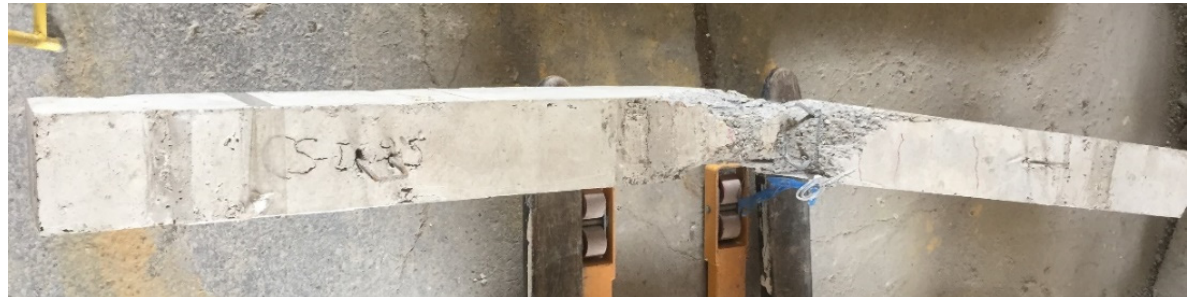
Figure 12. Lateral buckling failure of specimen CS ‐ I (top view).